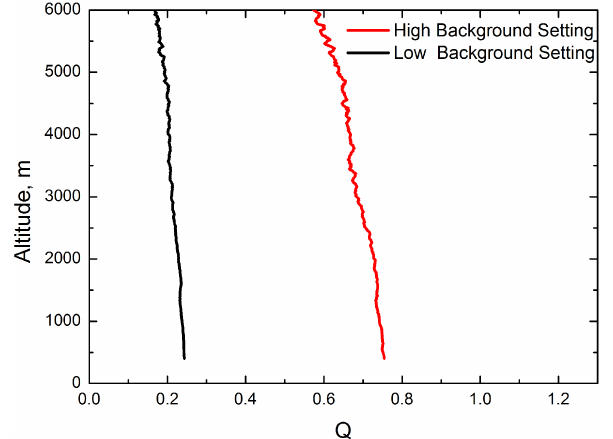
Figure 9. Same as Fig. 8 but against radiosonde temperature at the same height. In addition to the measurements, simulation data for the two settings are shown. In red and black are the measured val- ues for Q with the statistical error, and in blue and violet the corre- sponding